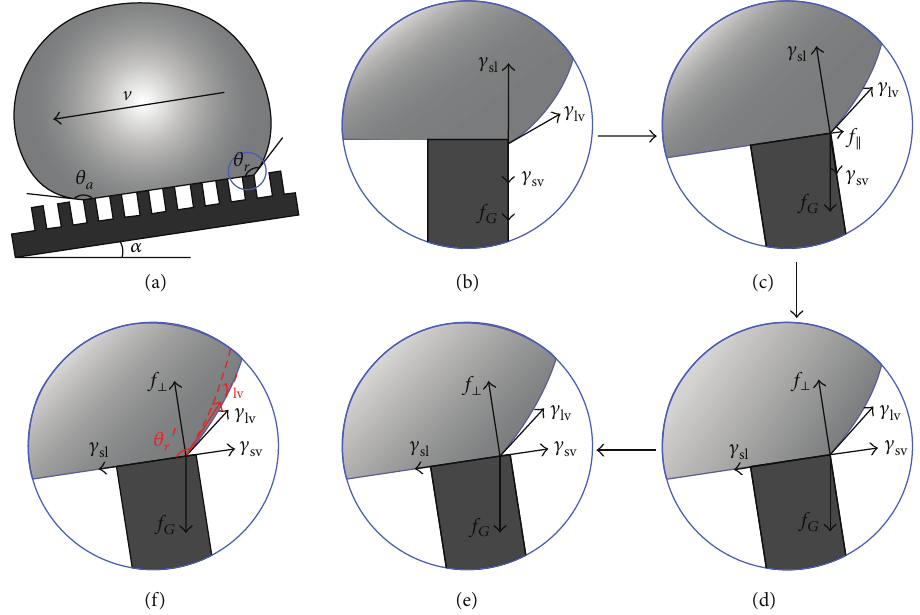
Figure 8: Force analysis of the receding contact line on micropillared surfaces.